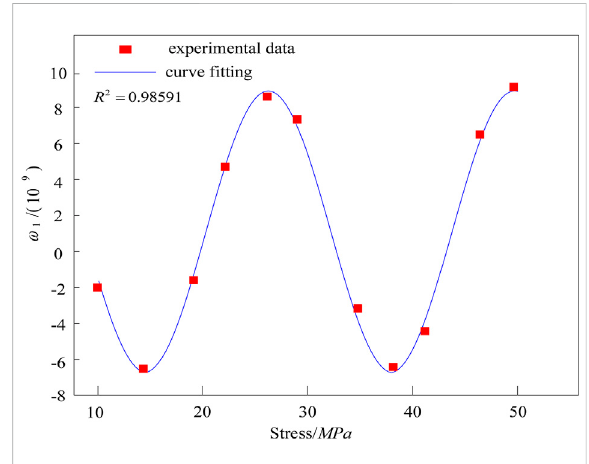
FIGURE 7 Relationship between characteristic correlation coef fi cient ω 1 and